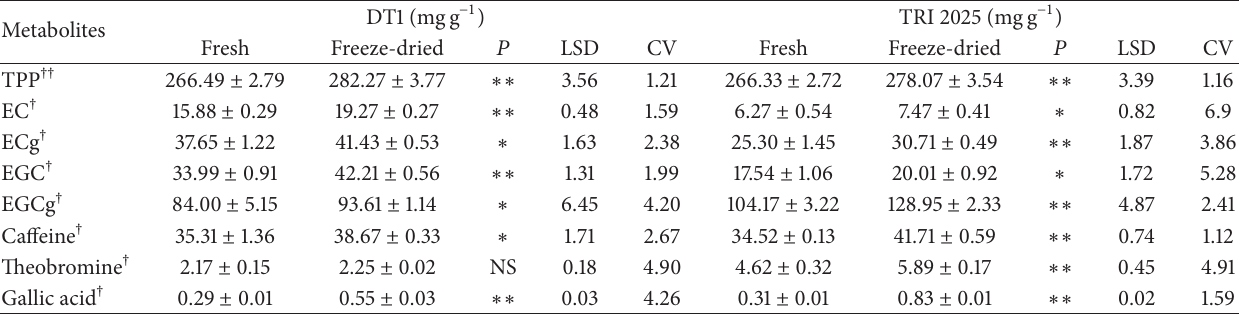
Table 2: Metabolite composition of tea flush of cultivars DT1 and TRI 2025 determined using two methods of sampling with fresh tea flush (conventional procedure) and freeze-dried tea flush (new procedure).